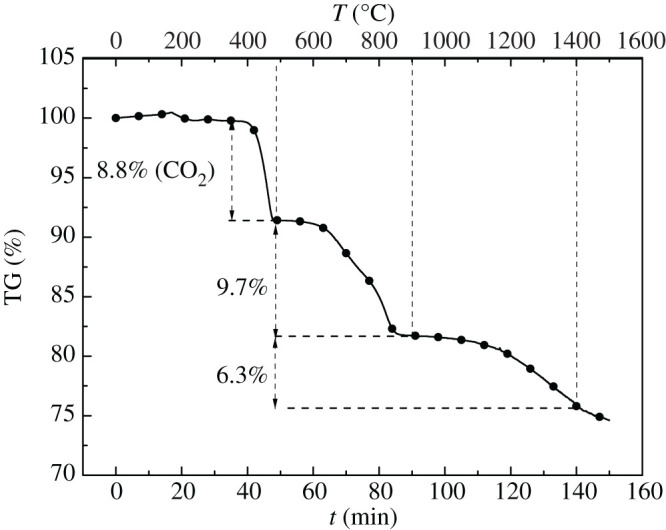
TG curve of the continuous casting mould flux. (Note: the weight loss before 500°C could be ignored considering the decomposition reaction of Na2CO3, as follows. Na2CO3 ≜ Na2O + CO2↑).